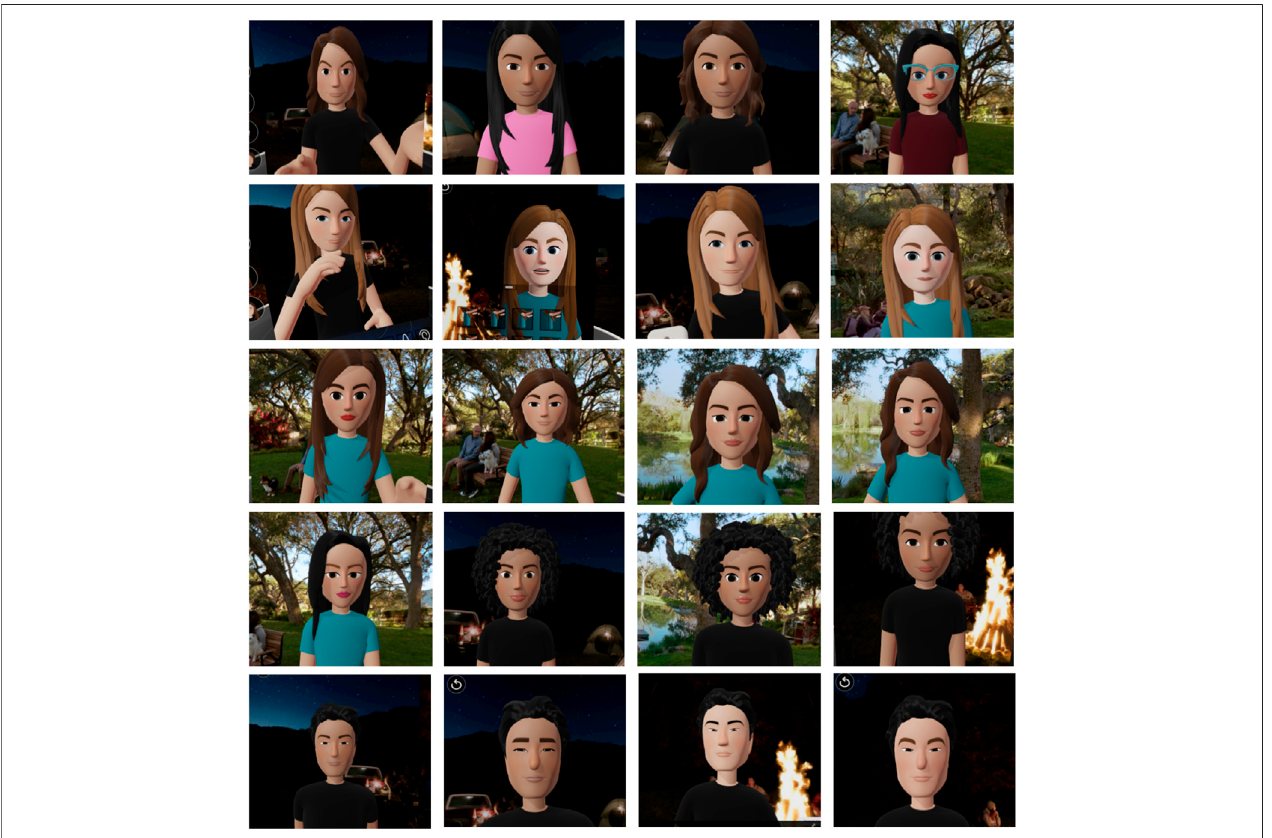
FIGURE 2 | Participants created their avatars before joining the shared environment every session. Each row shows screenshots of one participant ’ s avatar over time.